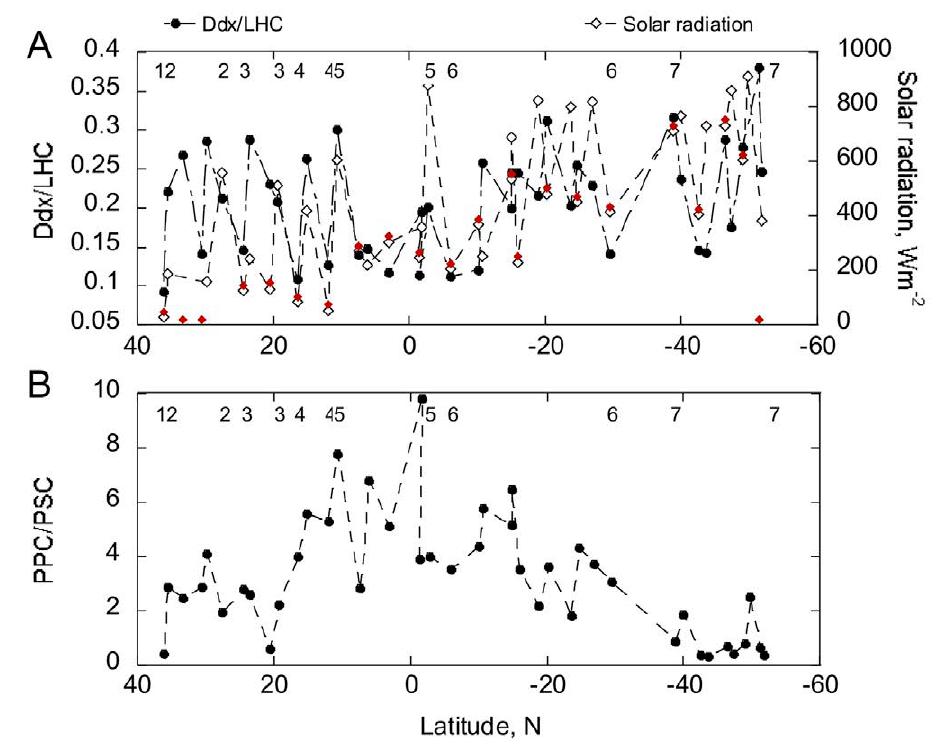
Fig. 4. – Latitudinal variation along the TransPEGASO transect of Ddx/LHC and solar radiation (W m –2 ) (A), and PPC/PSC (B). The red diamonds in A designate the morning stations and the numbers above the top or bottom axes indicate the provinces: 1, MEDI; 2, NAST-E; 3, CNRY; 4, NATR; 5, WTRA; 6, SATL; 7,